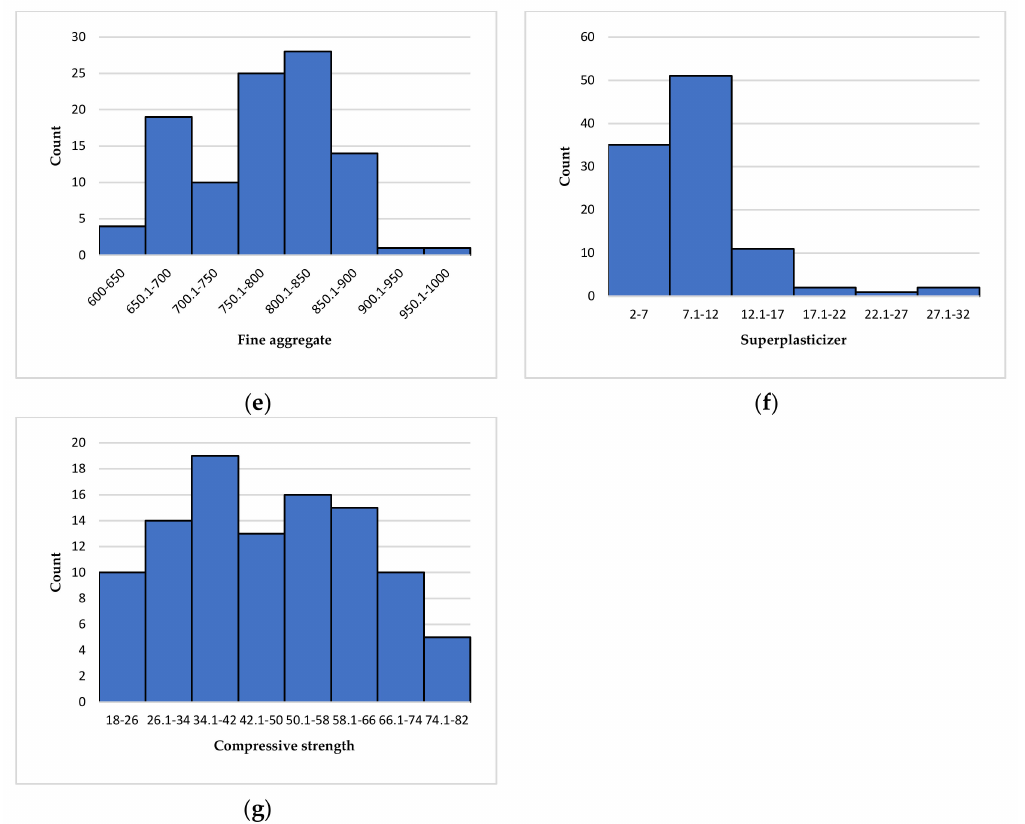
Figure 1. Frequency distribution histogram of variables. ( a ) Cement; ( b ) Water; ( c ) Blast furnace slag; ( d ) Coarse aggregate; ( e ) Fine aggregate; ( f ) Superplasticizer; ( g ) Uniaxial compressive